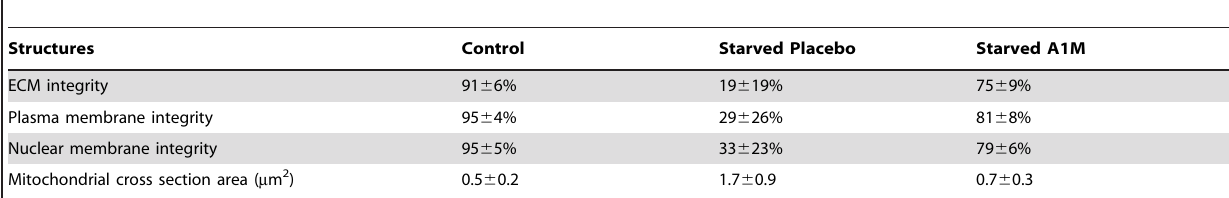
Table 1. Quantification of values for the surface areas obtained by transmission electron microscopy of the placenta tissue samples.